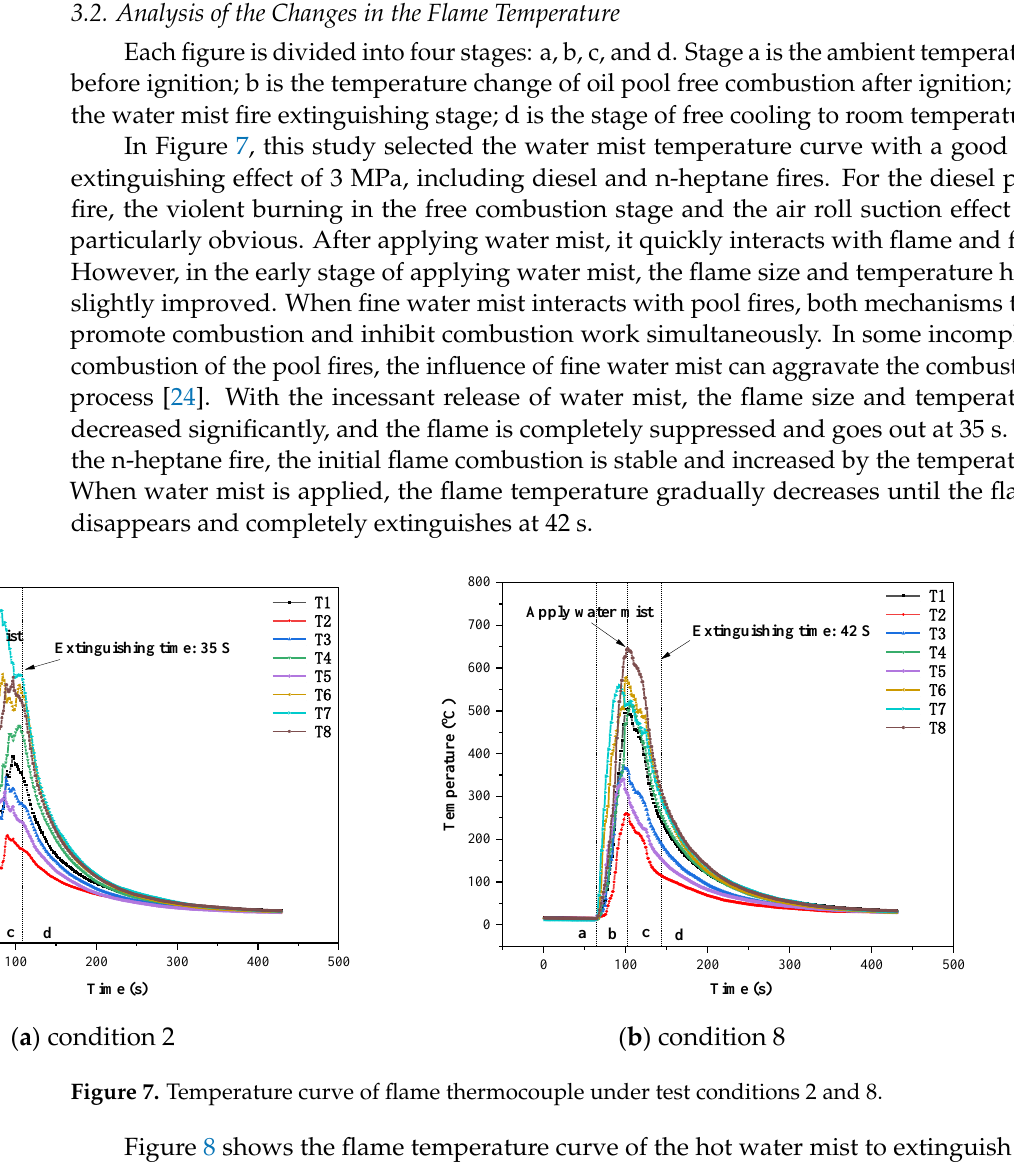
Figure 8. Temperature curve of flame thermocouple under test conditions 17 and 18. With the increase of pressure, the initial combustion promoting stage of hot water mist will disappear. When the hot water mist acts on the flame and fuel, it absorbs more heat than the cold water mist. The cooling effect is noticeable, and the fire extinguishing efficiency is greatly improved. When the hot water mist acts on fire, it will be vaporized to form steam after reaching the boiling point, expelling oxygen and forming a local an- oxic state. The asphyxiation effect is noticeable [25]. In addition, the droplet size of hot